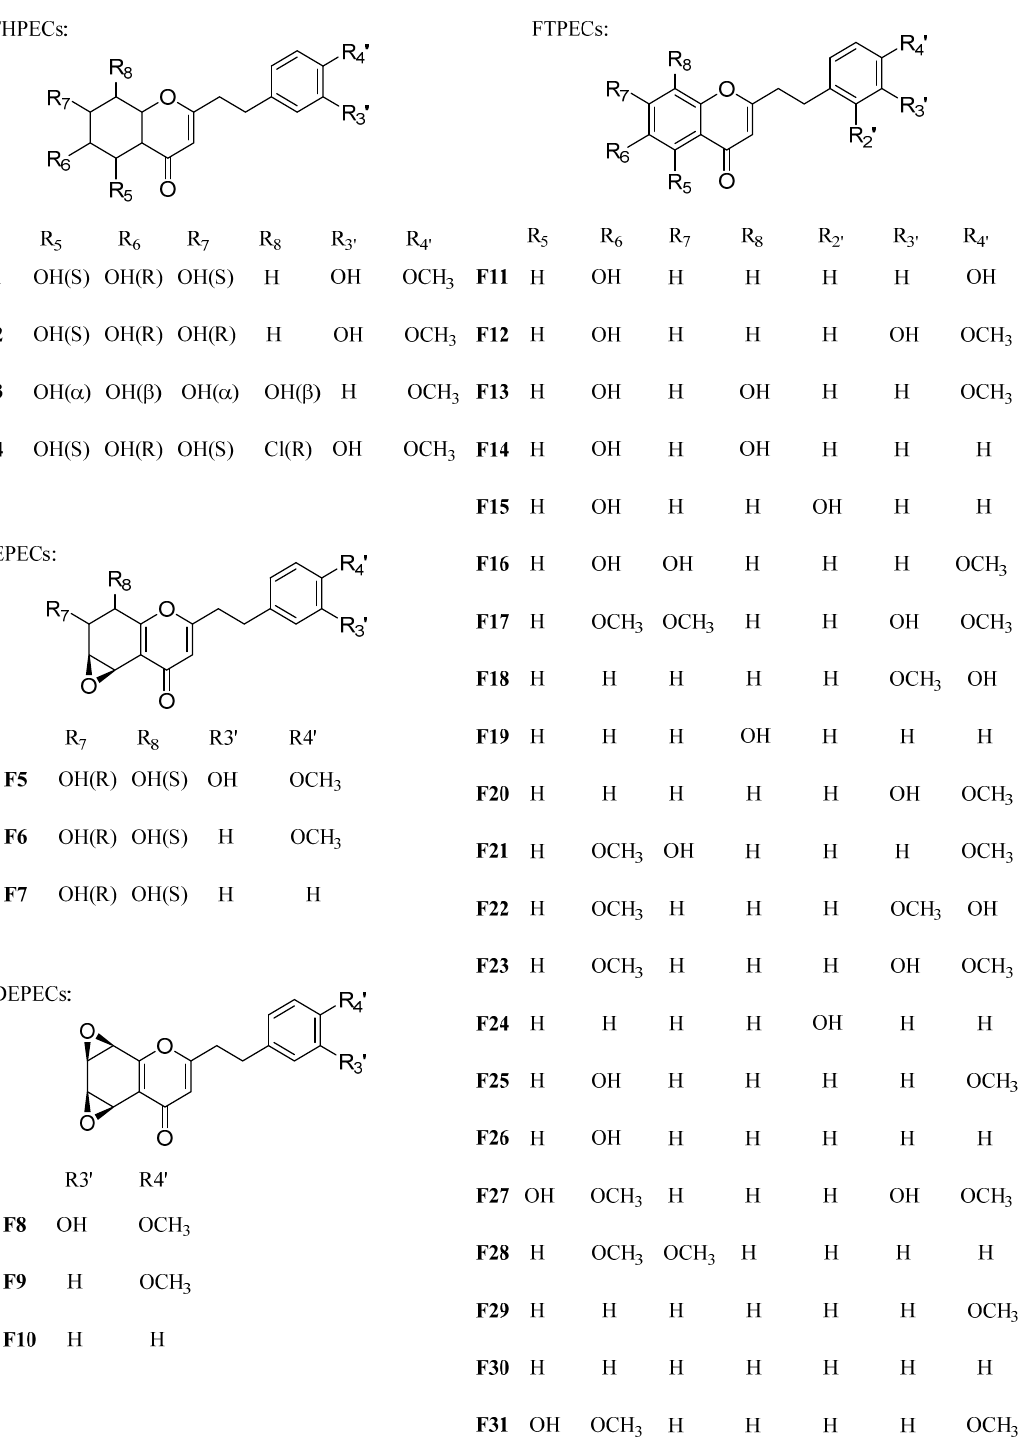
Figure 1. The structure of reference compounds F1~F31. (please use the figure) For twenty-one FTPECs in the reference compounds, their characteristic fragmentations were benzyl ions and/or chromone moiety ions. In addition, the benzyl ions observed in the MS spectrum of these four types chromones were the same, and the typical ions included m/z 91 [C 7 H 7 ] + , 107 [C 7 H 6 + OH] + , 121 [C 7 H 6 + OCH 3 ] + , 137 [C 7 H 5 + OH + OCH 3 ] + , 151 [C 7 H 5 + 2OCH 3 ] + . Figure 2 presents examples of the MS 2 fragmentation behavior from each type of